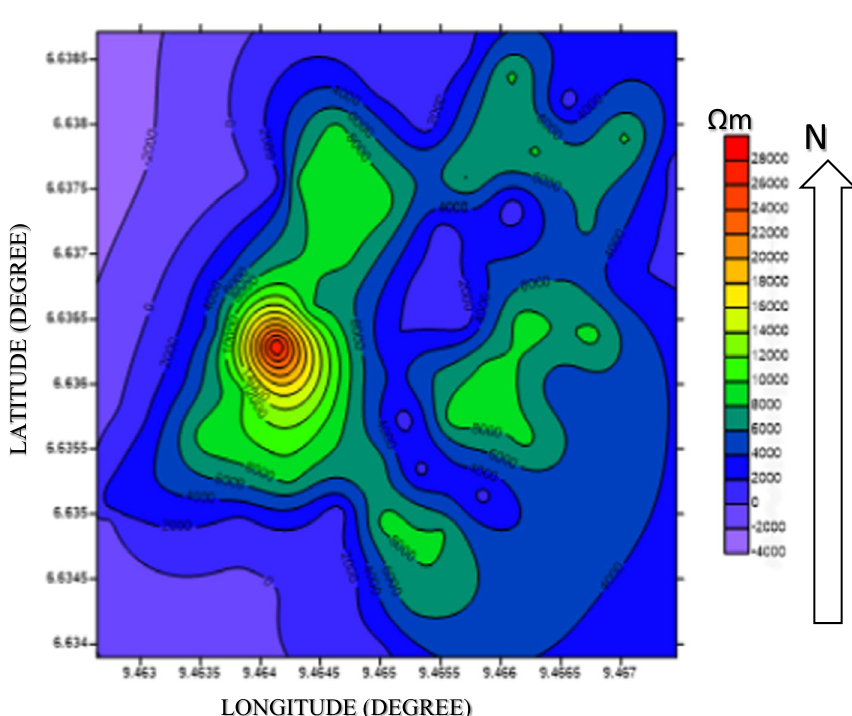
Fig. 5 Iso-resistivity contour map of the third